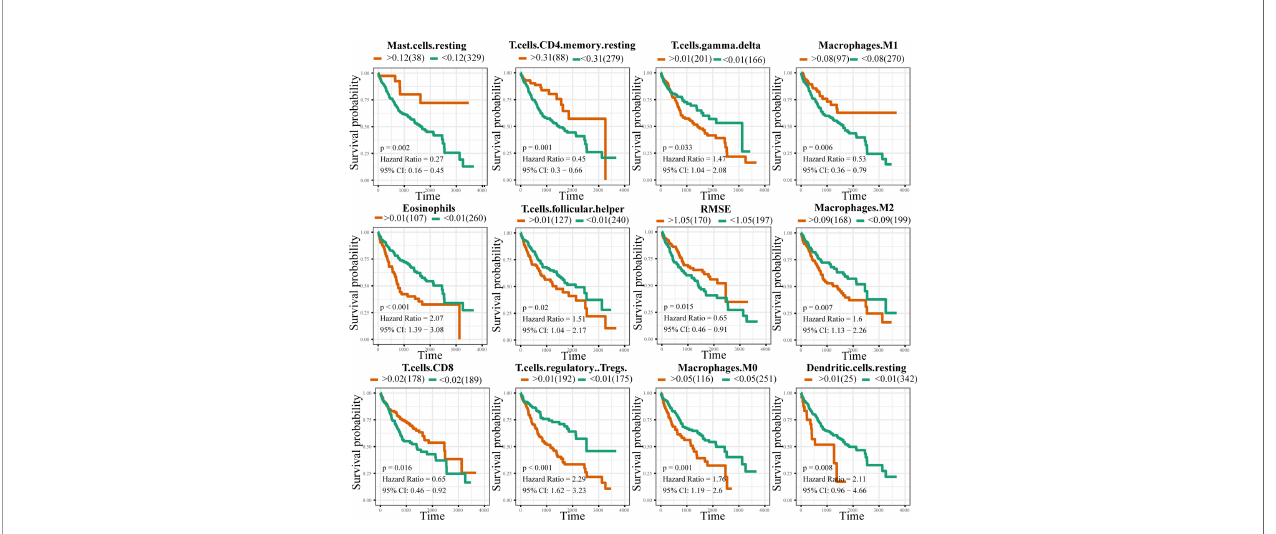
FIGURE 6 | Correlation between immune cell in fi ltration and LIHC prognosis. Orange and green colours indicate the high- and low-risk groups, respectively.